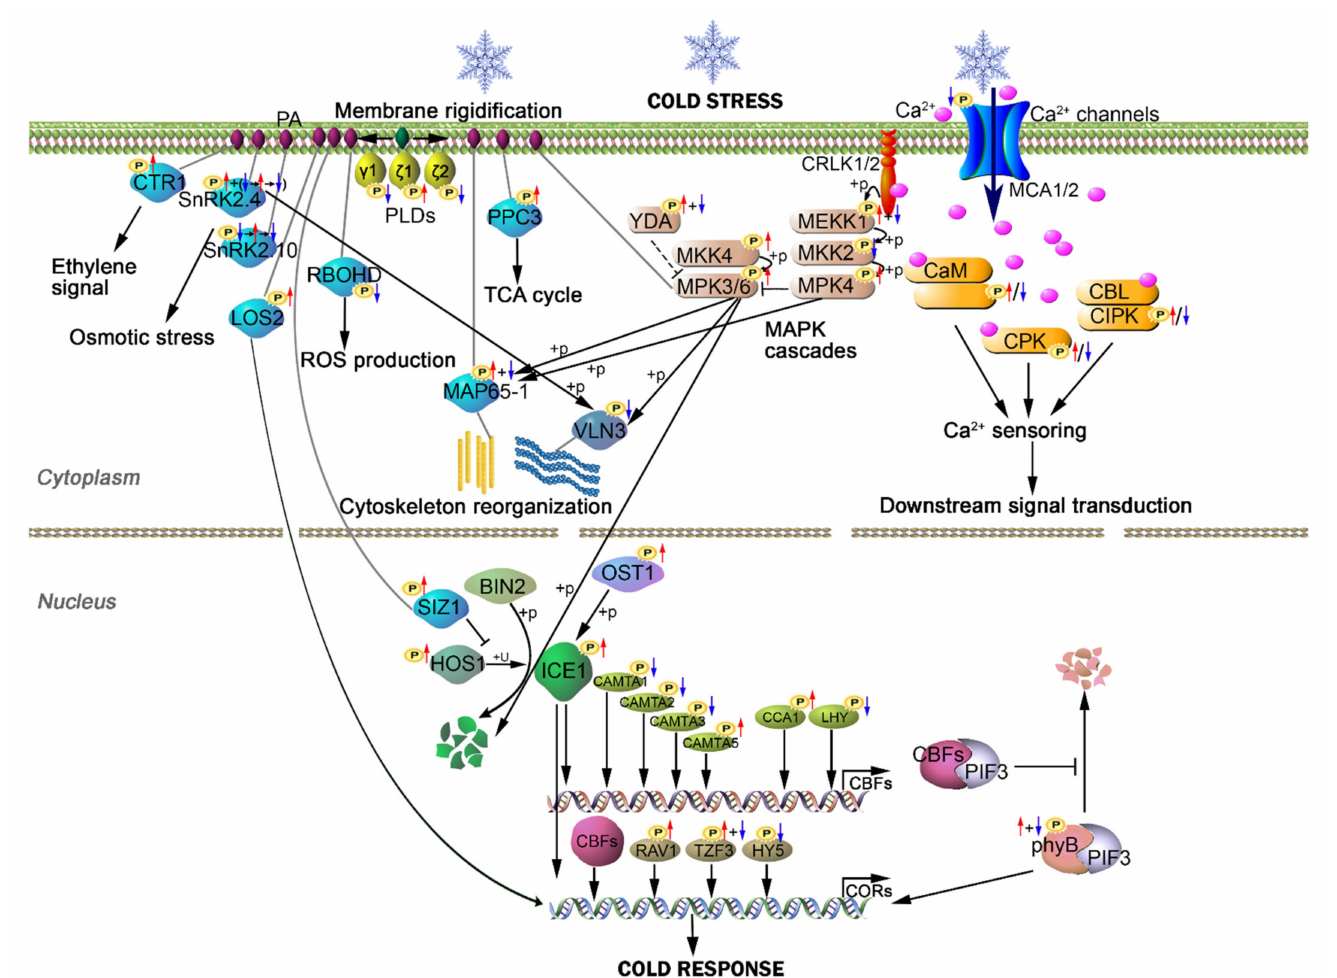
Figure 6. Schematic model illustrating protein phosphorylation and dephosphorylation events during early cold response in Arabidopsis based on our phosphoproteome study. At the onset of cold treatment, the cell membrane rigidification, cytoskeleton reorganization and cytosolic Ca 2+ increasing occur rapidly, followed by activation of cold signal transduction pathways such as Ca 2+ signal relay and MAPK cascades, and then transcription factors respond to cold signal and transcription regulation occurs. MCA1 is a Ca 2+ permeable mechanosensitive channel which contributes to the cold-induced transient cytosolic Ca 2+ increasing. CaMs, CBLs, CIPKs and CPKs decode and relay Ca 2+ signals to the downstream signal transduction. The lipid-derived PA serve as important signaling phospholipids and have multi-regulatory functions by binding proteins involved in various biological processes. MAP65-1 and VLN3 function in linking up cytoskeleton with other signal pathways including phospholipid signal and MAPK cascades. The key transcription factor ICE1 in cold signal transduction is mainly regulated by cold at post translational modification level. OST1 phosphorylates and activates ICE1, while MPK3/6 and BIN2 phosphorylate ICE1 and promote its degradation. HOS1 ubiquitinates ICE1 and mediates its degradation while SIZ1-mediated sumoylation of ICE1 inhibits this process. The cold-induced crucial transcription factors CBFs are transcriptionally regulated by many transcription factors, including ICE1, CaM-binding transcription activator family proteins (CAMTAs) and core components of circadian clock (CCA1 and LHY). In addition to CBFs , CORs gene expression are directly regulated by a number of transcription factors, such as RAV1, TZF3, HY5, and also ICE1. CBFs contribute to the stability regulation of phyB, a phytochrome which serves as thermosensor, by interacting with PIF3. Black arrows denote activation while lines ending with a bar indicate inhibition; gray lines denote interaction between PA and its target proteins; +P and +U beside the black arrows denote phosphorylation and ubiquitination events respectively; red up arrows beside the small P icons which are surrounded by yellow circles indicate upregulated phosphopeptides while the blue down arrows indicate downregulated ones identified in this